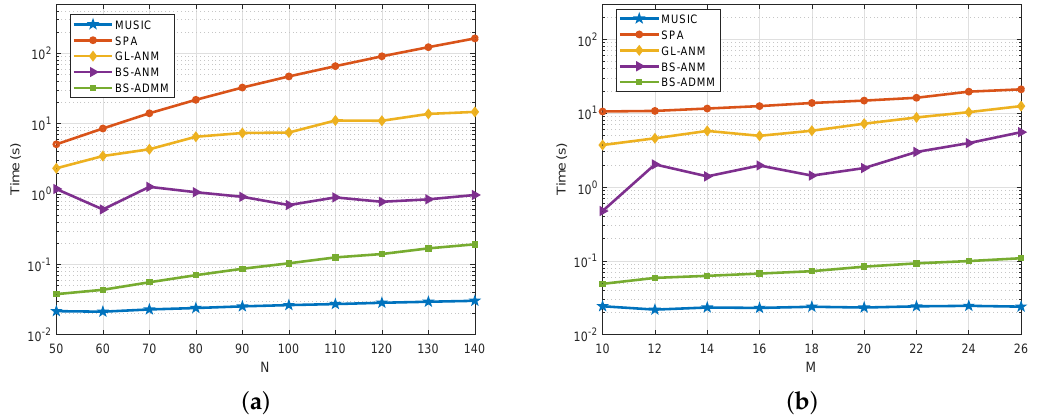
Figure 3. ( a ) Runtime versus the number of sensors N ; ( b ) Runtime versus the dimension of the beamspace M .